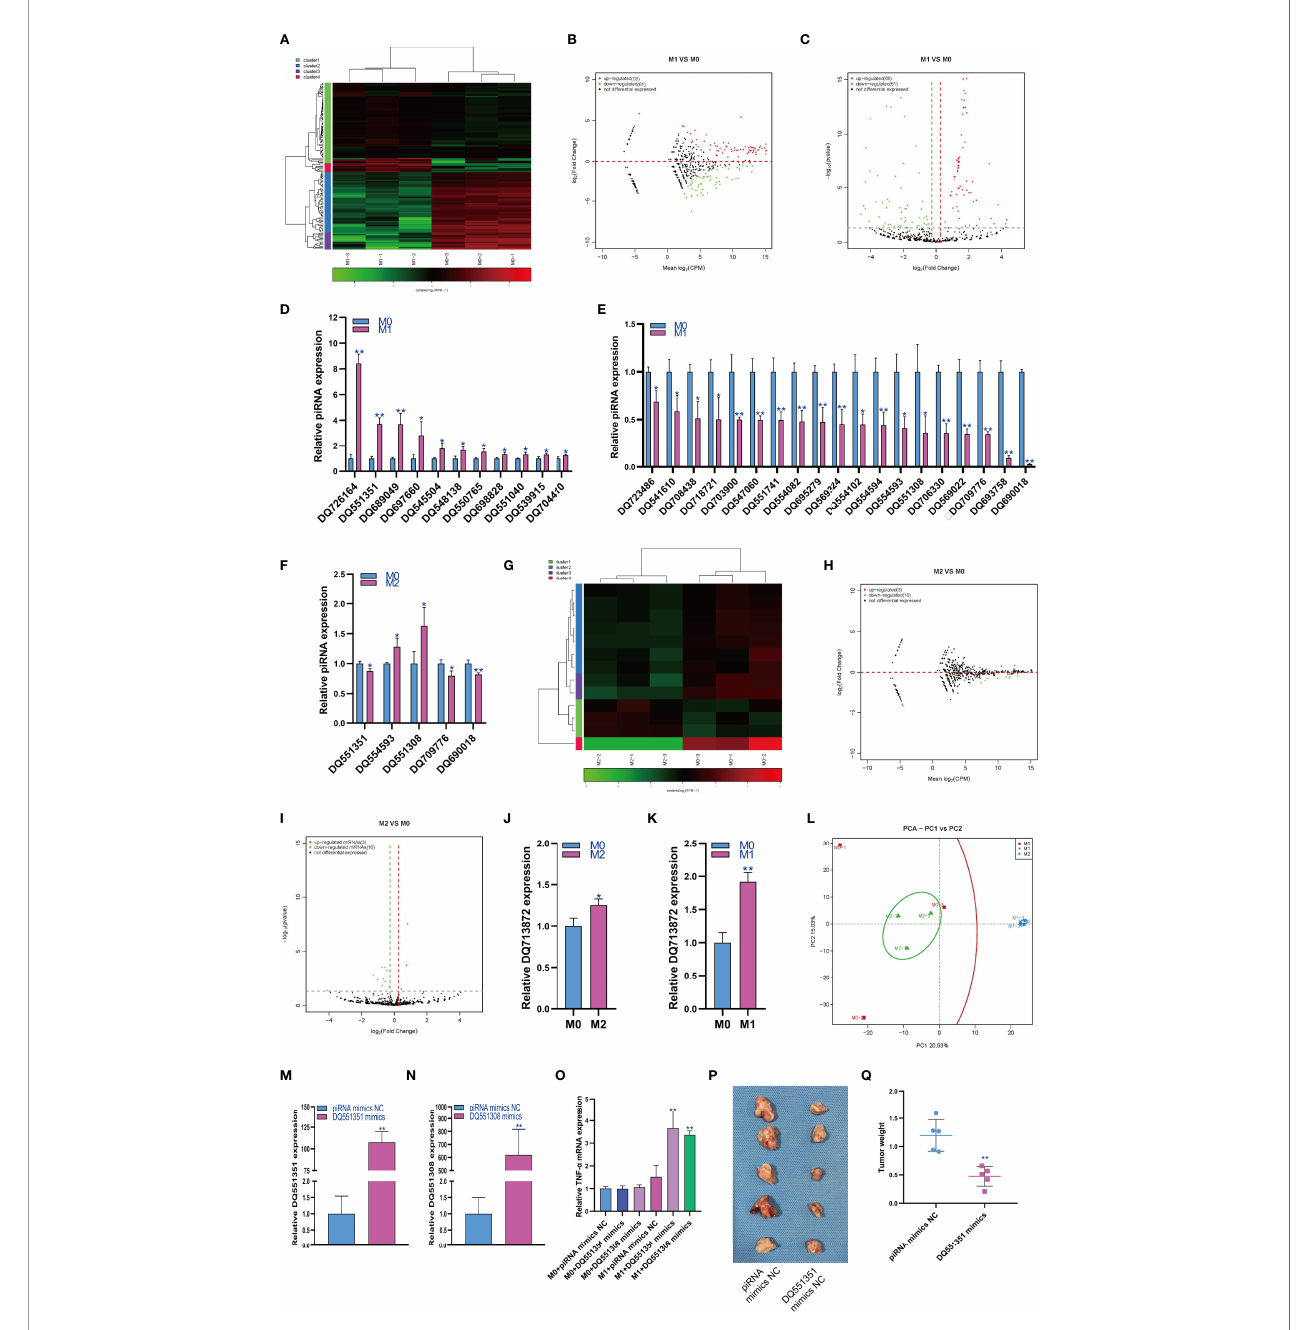
FIGURE 2 | Changes in piRNA expression during macrophage polarization. Hotmap (A) , MA (B) and volcano plot (C) show the small RNA sequencing results of the expression of piRNA in M0 and M1 macrophages. (D) The expression of piRNA upregulated in M1 macrophages as detected by qPCR. (E) The expression of piRNA was downregulated in M1 macrophages as detected by qPCR. (F) The expression of piRNA in M2 macrophages as detected by qPCR. Hotmap (G) , MA (H) and volcano plot (I) show the small RNA sequencing results of the expression of miRNA in M0 and M2 macrophages. (J) The expression of piRNA in M2 macrophages as detected by qPCR. (K) The expression of piRNA in M1 macrophages as detected by qPCR. (L) PCA of piRNA expression in M0, M1 and M2 macrophages. * indicates p < 0.05 compared to M0, and ** indicates p < 0.01 compared to M0. (M) The expression of piRNA DQ551351 in RAW264.7 cells transfected with piRNA mimics NC or piRNA DQ551351 mimics were detected by qPCR. (N) The expression of piRNA DQ551308 in RAW264.7 cells transfected with piRNA mimics NC or piRNA DQ551308 mimics were detected by qPCR. (O) The expression of TNF- a in RAW264.7 cells were detected by qPCR, * indicates p < 0.05 and ** indicates p < 0.01 compared to M1+ miRNA mimics NC group. (P) Photographs showed the size of the tumor in mouse injected with RAW264.7 cells with piRNA mimics NC or piRNA DQ551308 mimics. (Q) Tumor weight in mouse injected with RAW264.7 cells with piRNA mimics NC or piRNA DQ551308 mimics, ** indicates p < 0.01 compared to piRNA mimics NC